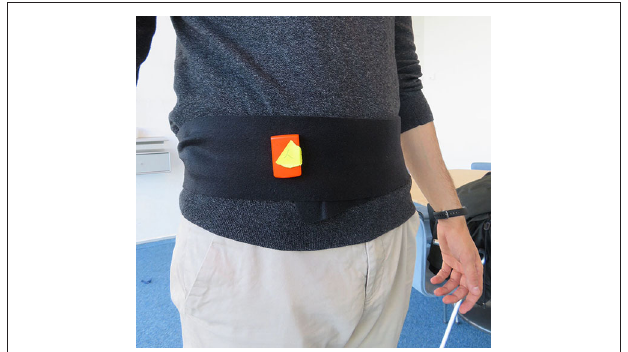
FIGURE 1 | Ear-level accelerometer placement used in the experiment.